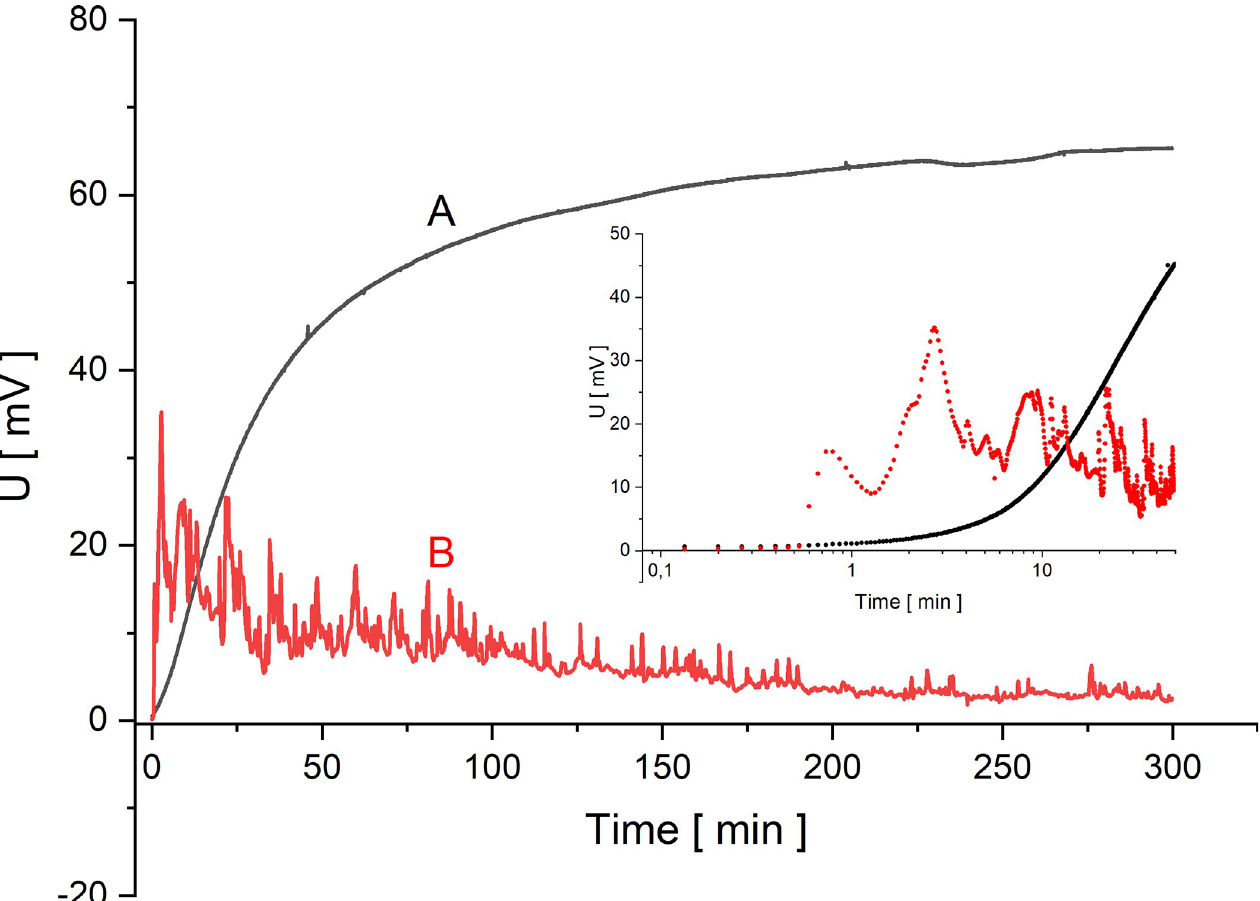
Fig 5. Voltage between electrodesin the chamberwith lower concentration as a functionof time for configurations A (black) and B (red) and for C h / C l = 5000.